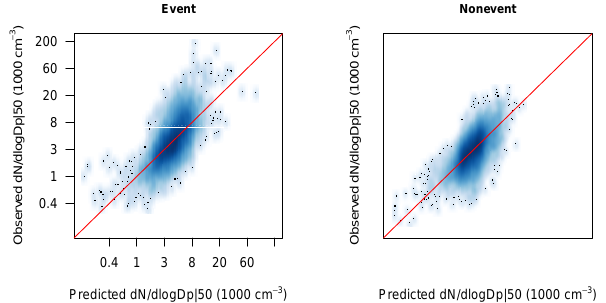
Fig. 5. Observed vs. predicted dN/d log D p | 50nm ( N 50 ) for event and non-event days in the combined dataset. Diagonal line represents the perfect fit and the tone of the colour shows the density of the data